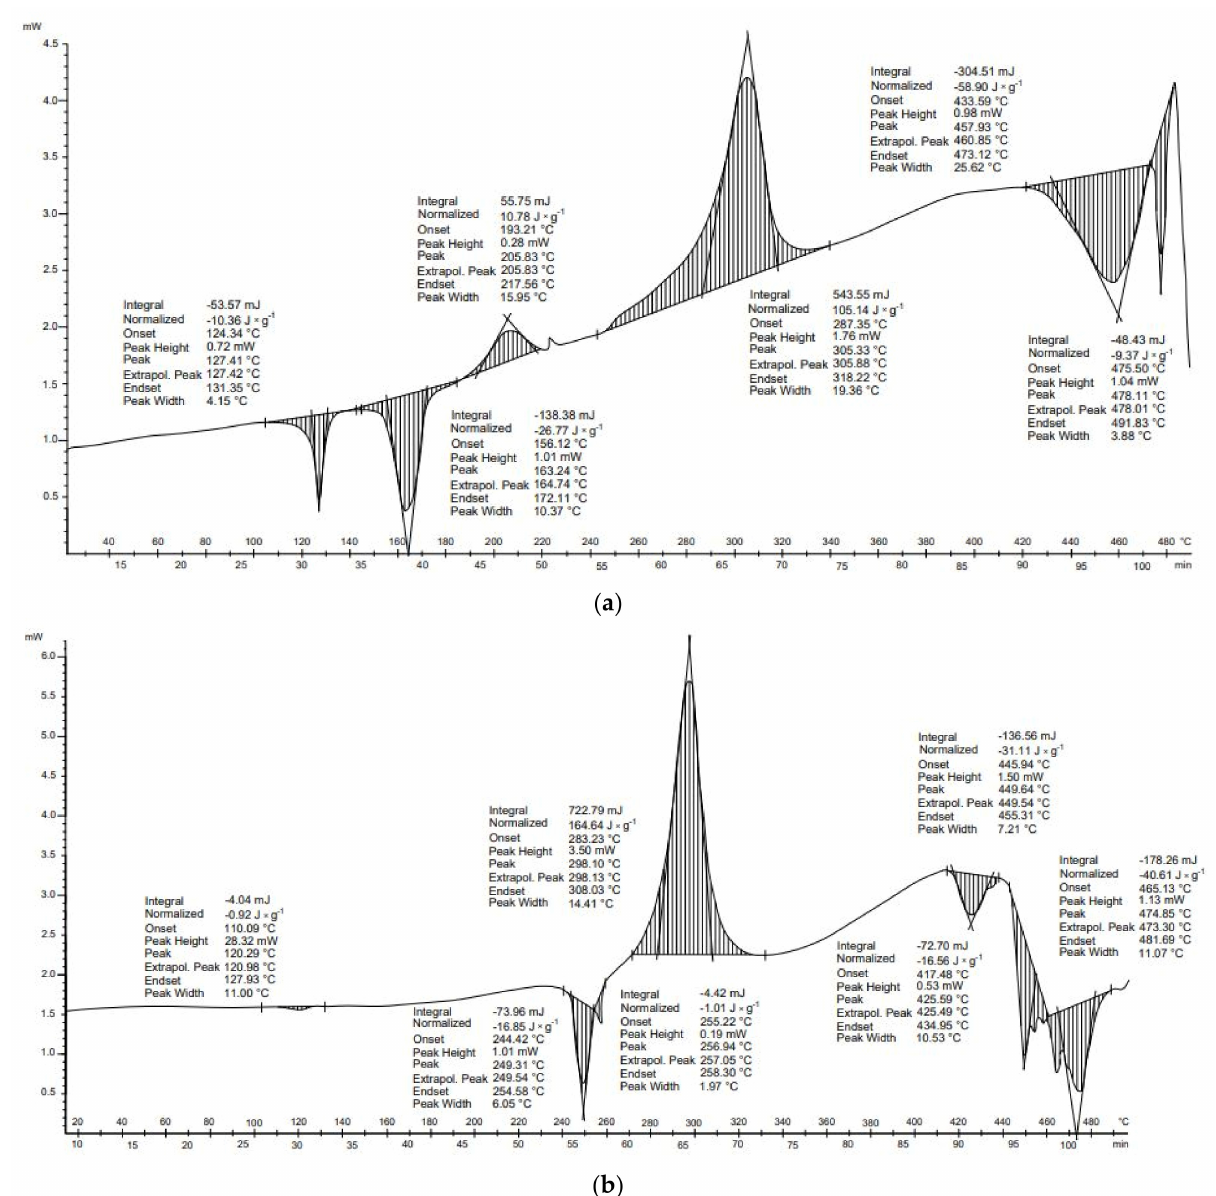
Figure 10. Characteristics of the DSC of hygiene waste: ( a ) diapers; ( b )